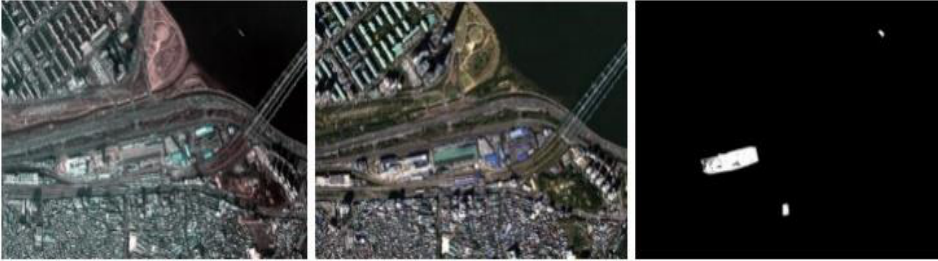
Figure 10. Test area 4 (3232 × 2206): ( left ) Image P, acquired in March 2014; ( middle ) Image C, acquired in October 2015; ( right ) Ground truth.